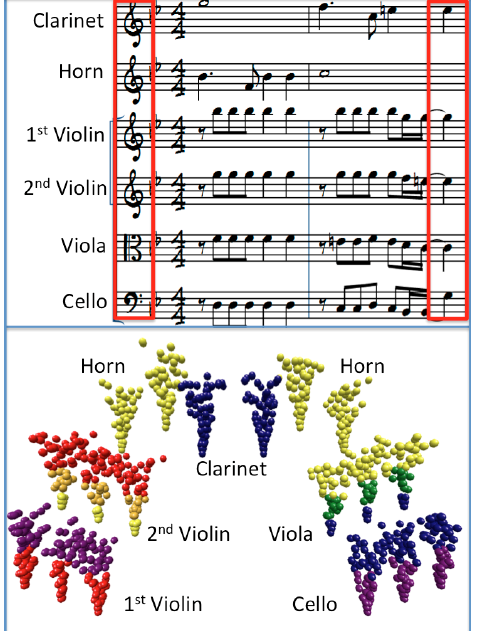
Fig. 11: Animation of the particle emitters, controlled by the Leap Motion : mapping of pitch from MIDI.